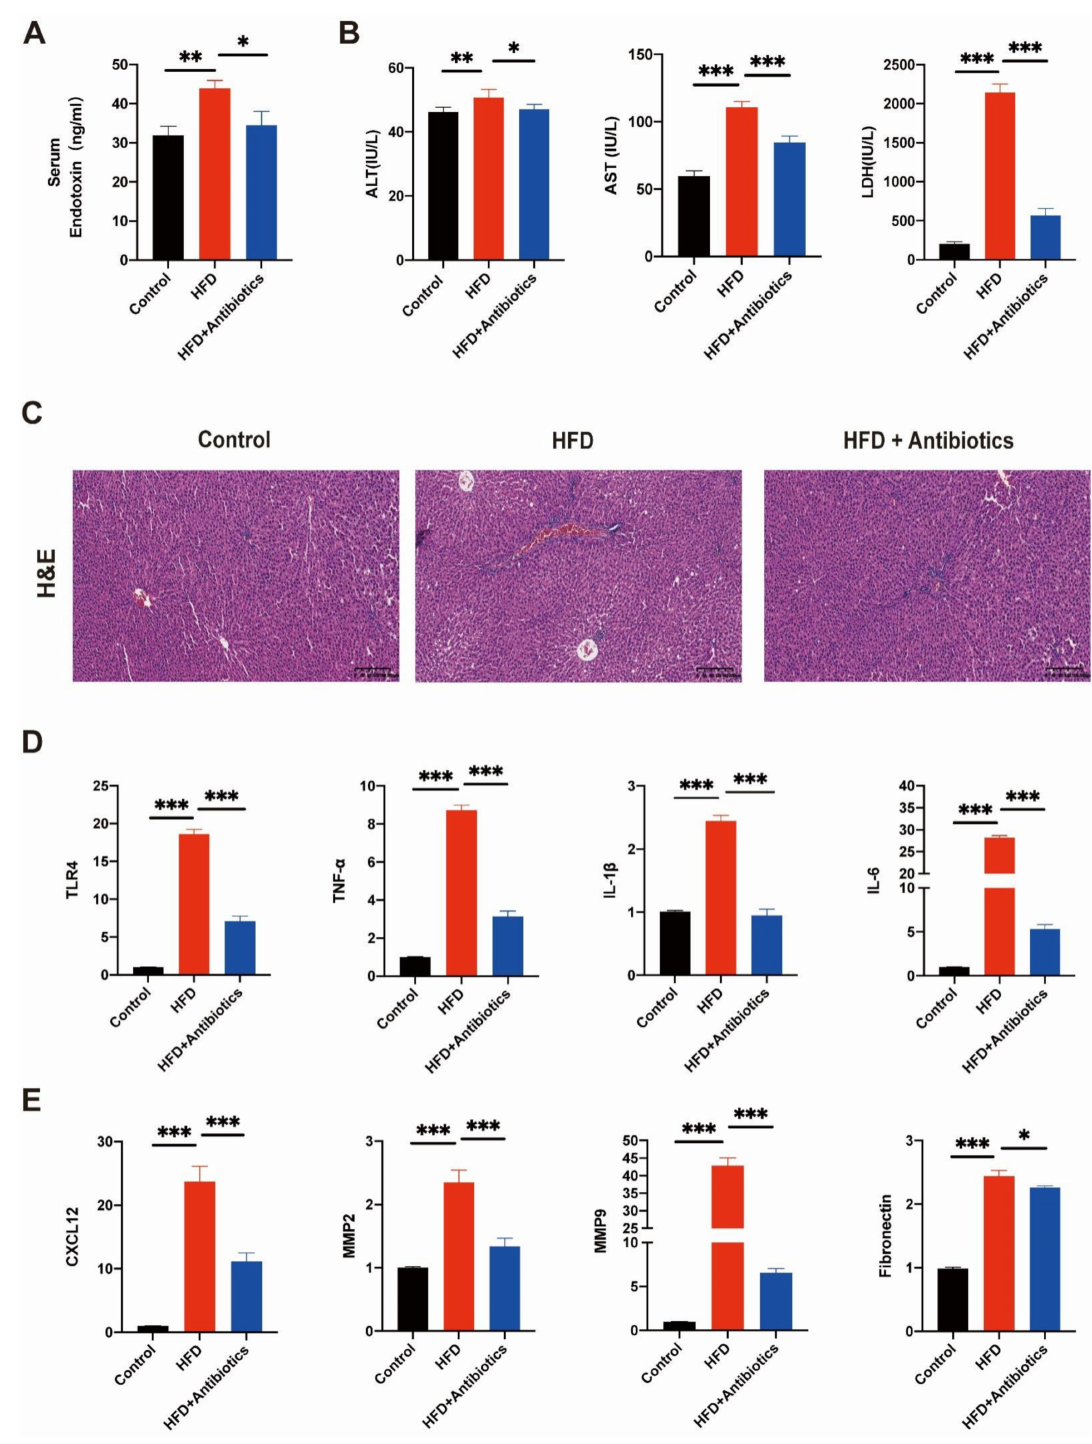
Figure 3. Treatment of a high-fat diet could induce liver damage and be engaged in the construction of metastasis microenvironment in rats. ( A ) The level of serum endotoxin was evaluated by serum endotoxin production assay. ( B ) Levels of serum ALT, AST, and LDH in rats at eight weeks of administration. ( C ) Haematoxylin and eosin staining of liver tissue sections collected from rats treated as above. Scale bars represent 200 µ m. ( D , E ) mRNA expression of IL-1 β , IL-6, TNF- α , TLR4, MMP9, Fibronectin, MMP2, and CXCL12 are shown as relative fold to control normalized to GAPDH. Data represent means ± SEM. * p < 0.05; ** p < 0.01; *** p < 0.001. (Control, n = 7; HFD, n = 7; HFD+Antibitics, n =